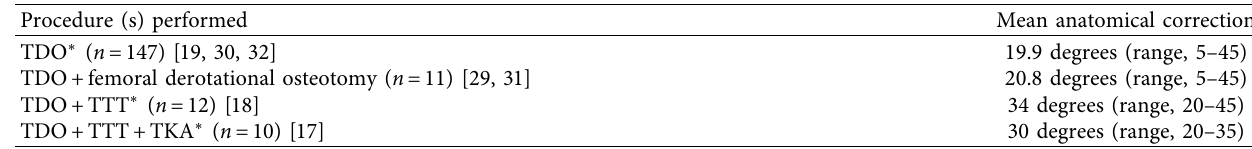
Table 3: Mean anatomical correction of each procedure or combination of procedures in the included studies. Tese fndings were confrmed by XR or CT. Procedure (s) performed Mean anatomical